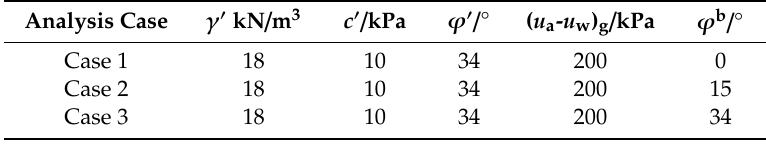
Figure 8. Comparison of the critical slip surface.